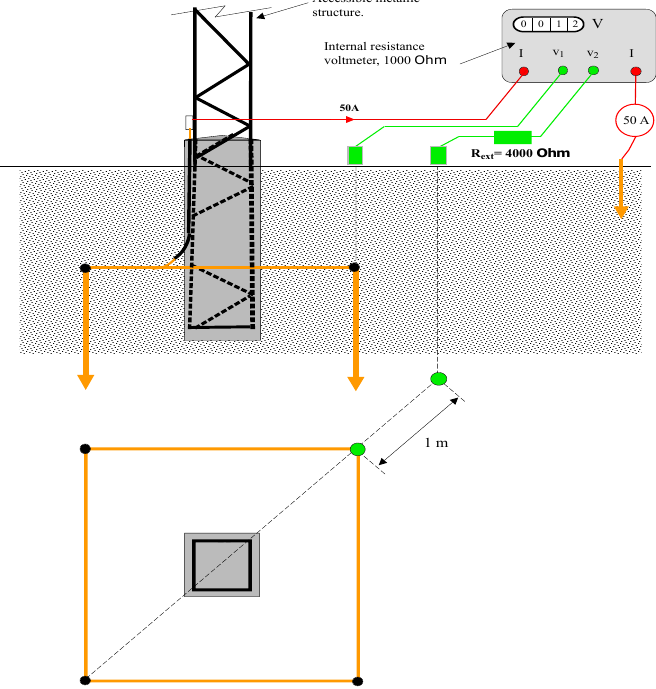
Figure 2. Step potential measurement for the grounding electrode of a power transmission line tower.